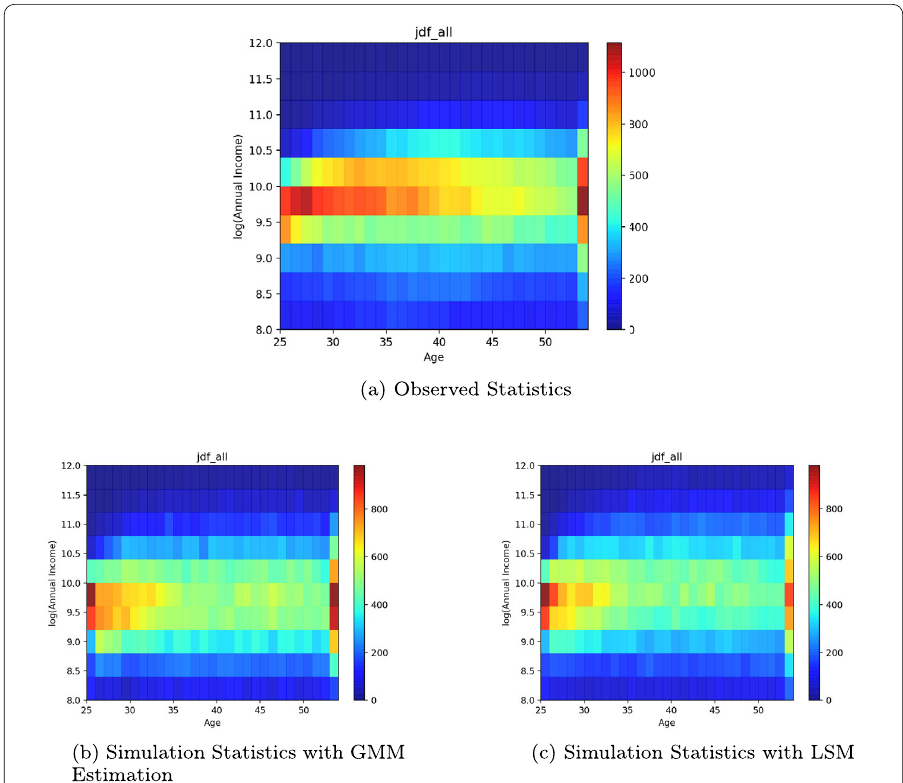
Figure 5 UK Labour Data Observed and Simulation All Years Pooled JDF between ages 25 and 55, the stripe of concentration at last column is due to concatenation of last two ages to fit the